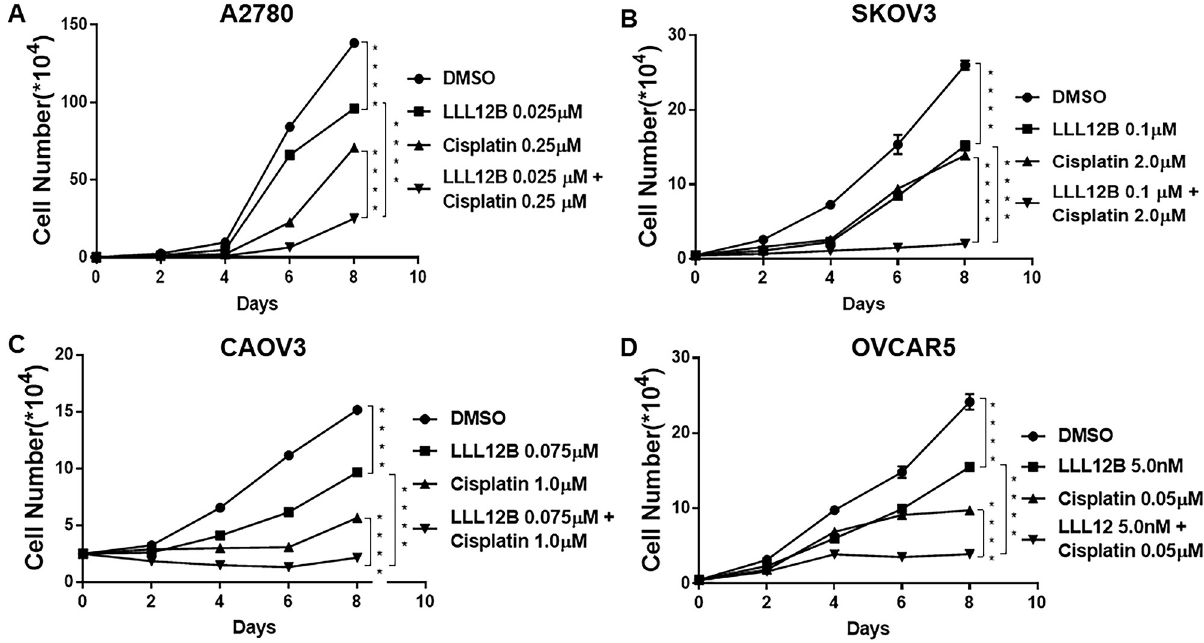
Fig 5. The effects of LLL12B, cisplatin, and drug combination on cancer cell growth. Cell growth assays were performed to evaluate cell proliferation ability of ovarian cancer cells. Cells were treated with LLL12B, cisplatin and their combination. The differences were found to be significantly different at �� p < 0.01 and ���� p < 0.0001. LLL12B alone or combined with cisplatin inhibited cell growth of ovarian cancer cells.